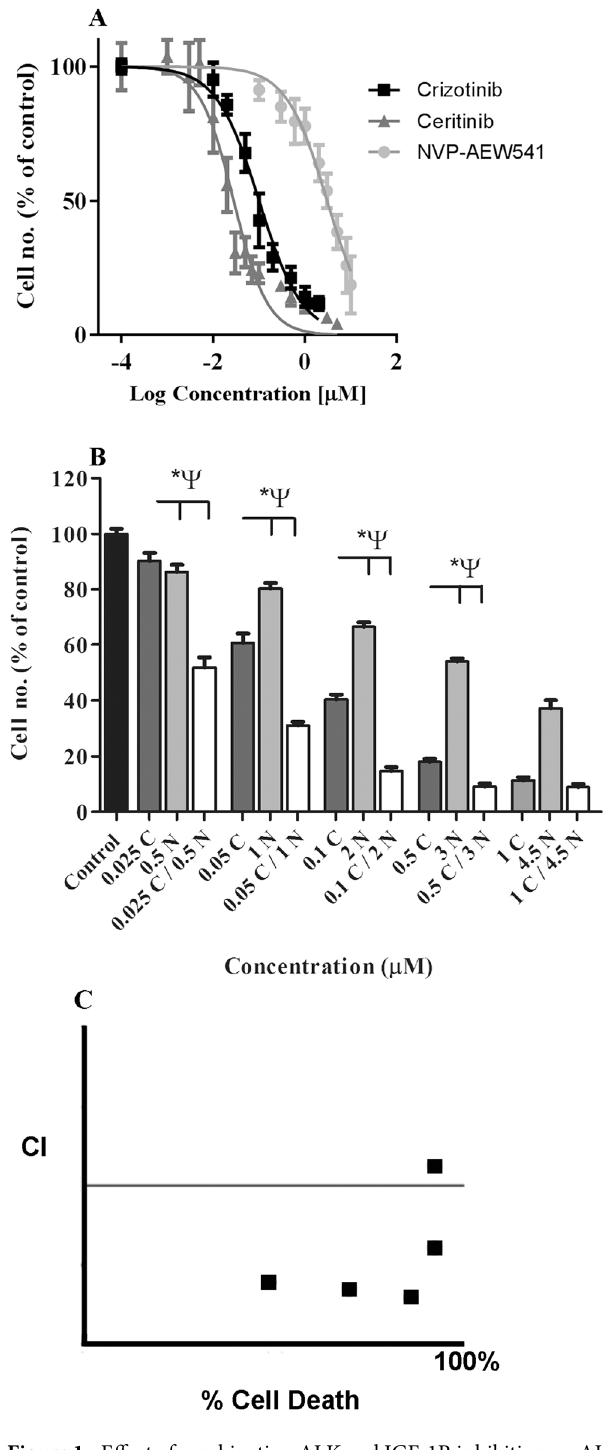
Figure 1. Effect of combination ALK and IGF-1R inhibition on ALK + H3122 lung cancer cells. ( A ) H3122 cell cytotoxicity of ALK inhibitors crizotinib and ceritinib, and IGF-1R inhibitor NVP-AEW541, data points are means and error bars are sd. ( B ) H3122 cell cytotoxicity of combinations of crizotinib and NVP-AEW541. Black bar is DMSO control, dark grey bars crizotinib alone, light grey bars NVP-AEW541 alone, and clear bars are combination of both. Error bars are SEM.( C ) Combination index plot for drug combinations in “B”. The horizontal line represents additivity, above the line inhibition, and below the line synergy. All data represent three independent experiments carried out in triplicate. * p < 0.05 for crizotinib vs. combination, Ψ p < 0.05 for NVP-AEW541 vs.